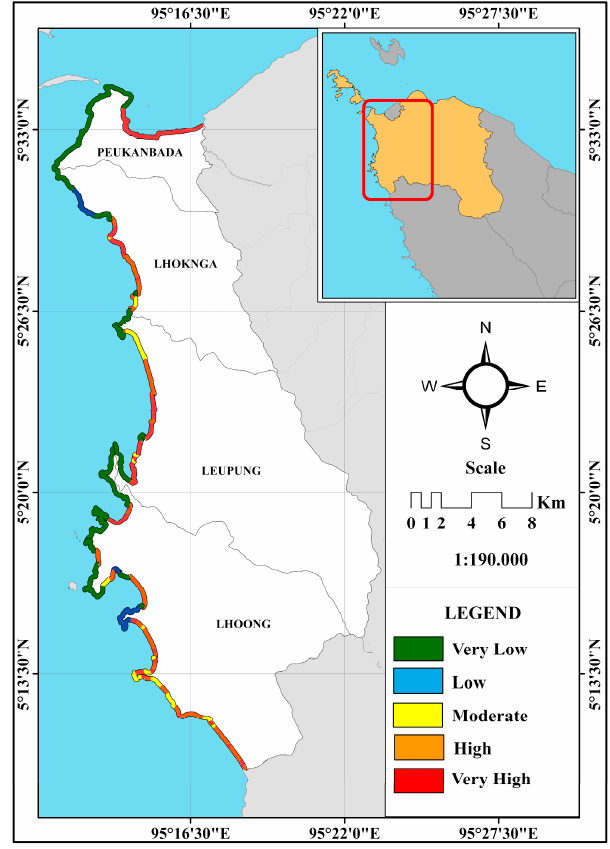
Figure 9. Coastal vulnerability of the west Aceh Besar region .